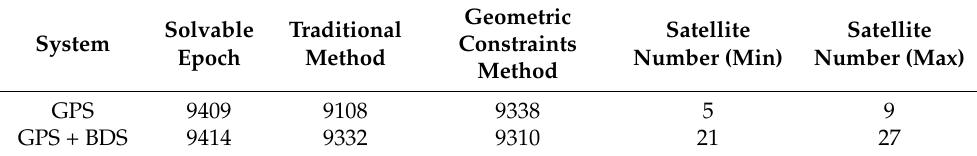
Table 1. The success rate of the geometric constraints method and the traditional method.